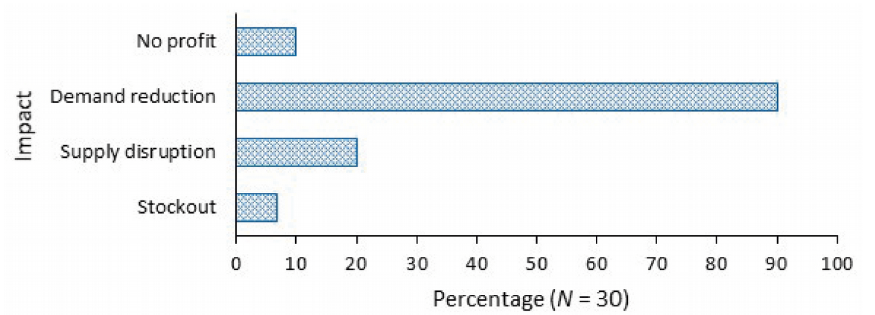
Figure 3. The impact of the COVID-19 pandemic on the retailers